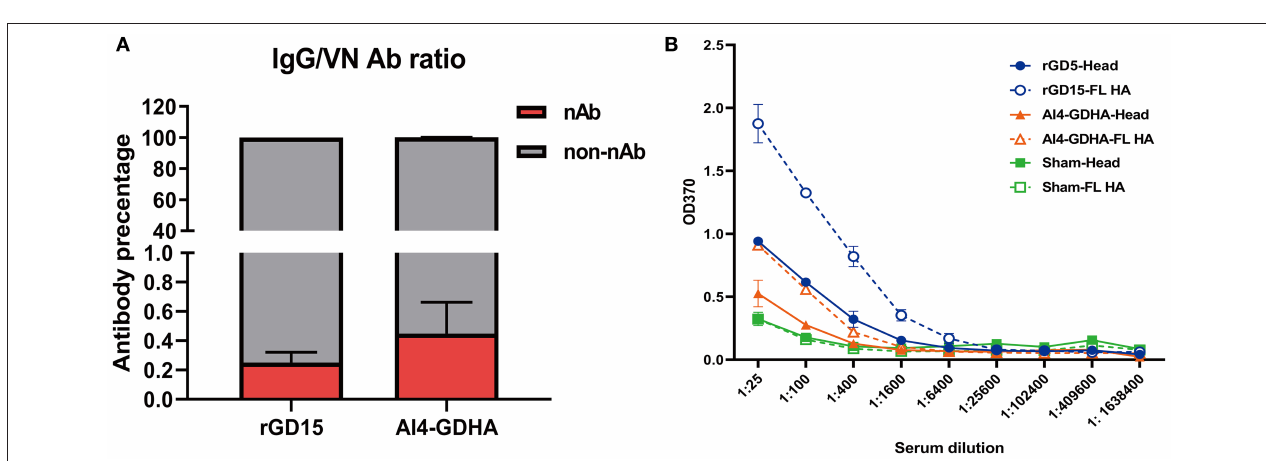
FIGURE 2 | Antibody response induced by NDV-vectored H7N9 vaccine in chickens. (A) HI titers against NDV vector. (B) HI titers against H7N9 virus. The dotted lines in (A,B) indicate the cutoff value for positive reading in HI assay (4 log 2 ). (C) VN antibody titers against H7N9 virus. (D) IgG titers determined by ELISA. Serum samples from individual chicken were pooled for measurement of VN and IgG titers. The dotted lines in (C,D) stand for the lower detection limit for VN test and ELISA.